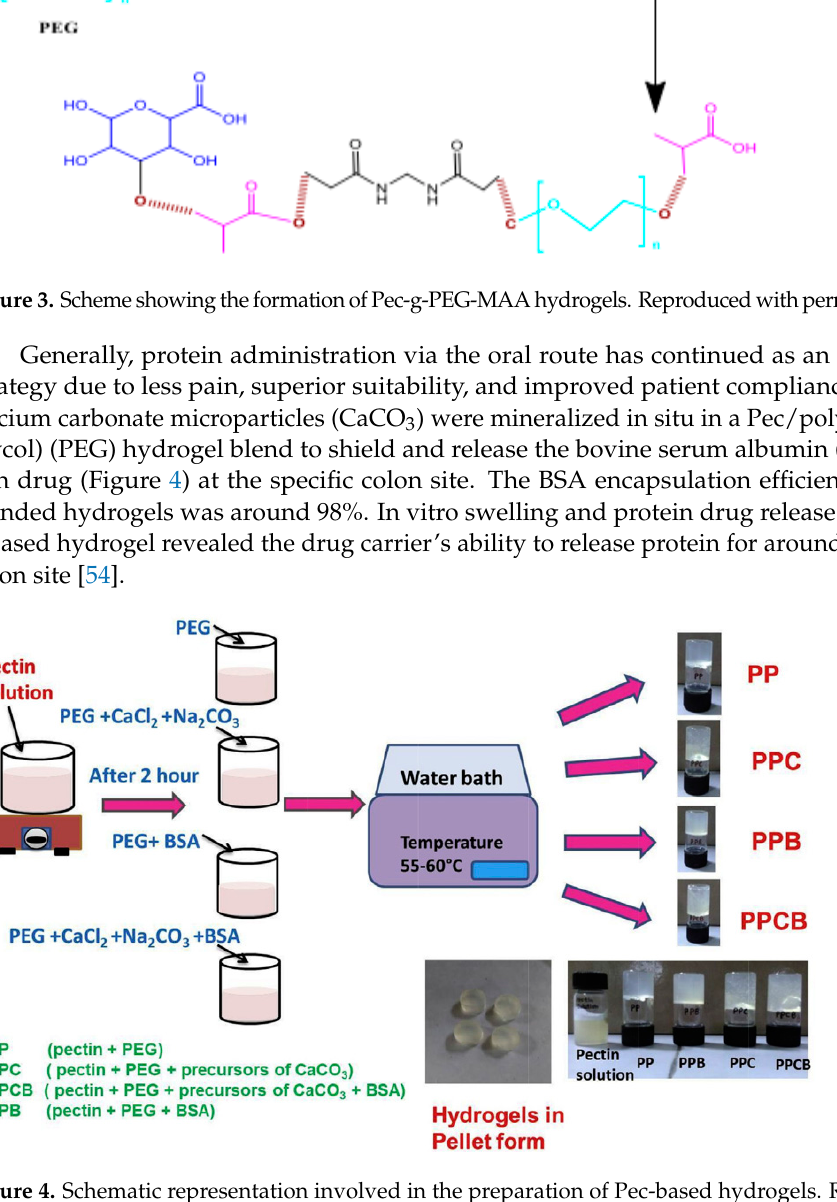
Figure 4. Schematic representation involved in the preparation of Pec-based hydrogels. Reproduced with permission [54]. with permission